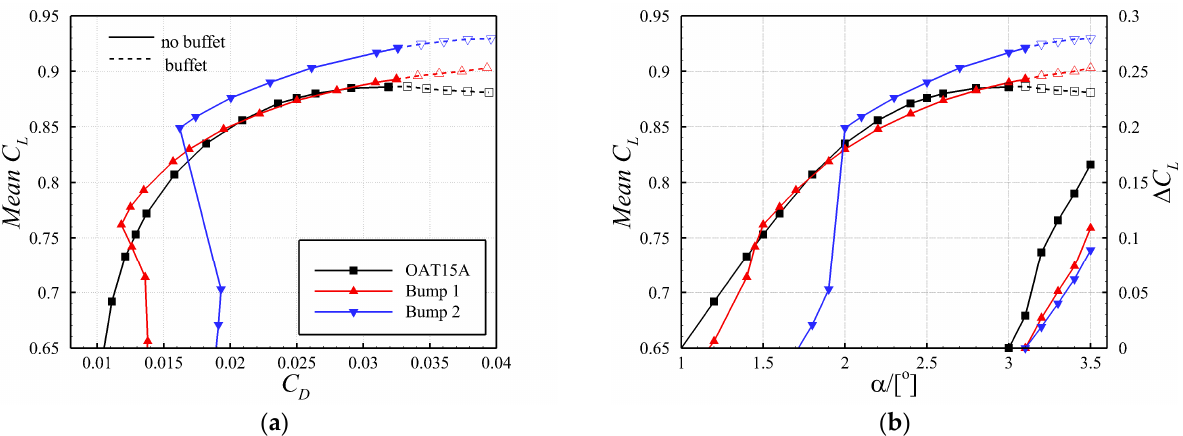
Figure 8. Aerodynamic performances of different configurations. ( a ) Drag polar. ( b ) Lift coefficient vs. angle of attack.